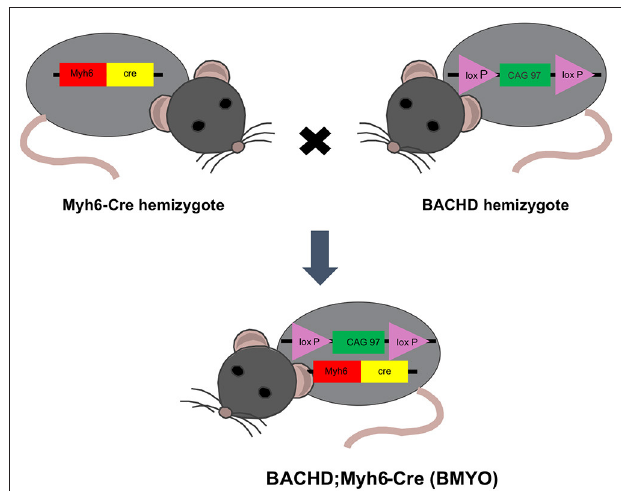
FIGURE 1 | Schematic representation of the breeding strategy used in the present study. Genetic reduction of mHTT expression in the heart of BACHD mice was achieved by crossing this transgene (hemizygous) with mice hemizygous for the cardiomyocyte-specific Myh6-Cre transgene. The full-length m HTT with two loxP sites enables cell specific reduction of m HTT using Cre-recombinase (Cre). Approximately 25% of the offspring were double transgenics (BACHD; Myh6-Cre), BMYO, with the mHTT floxed out in the